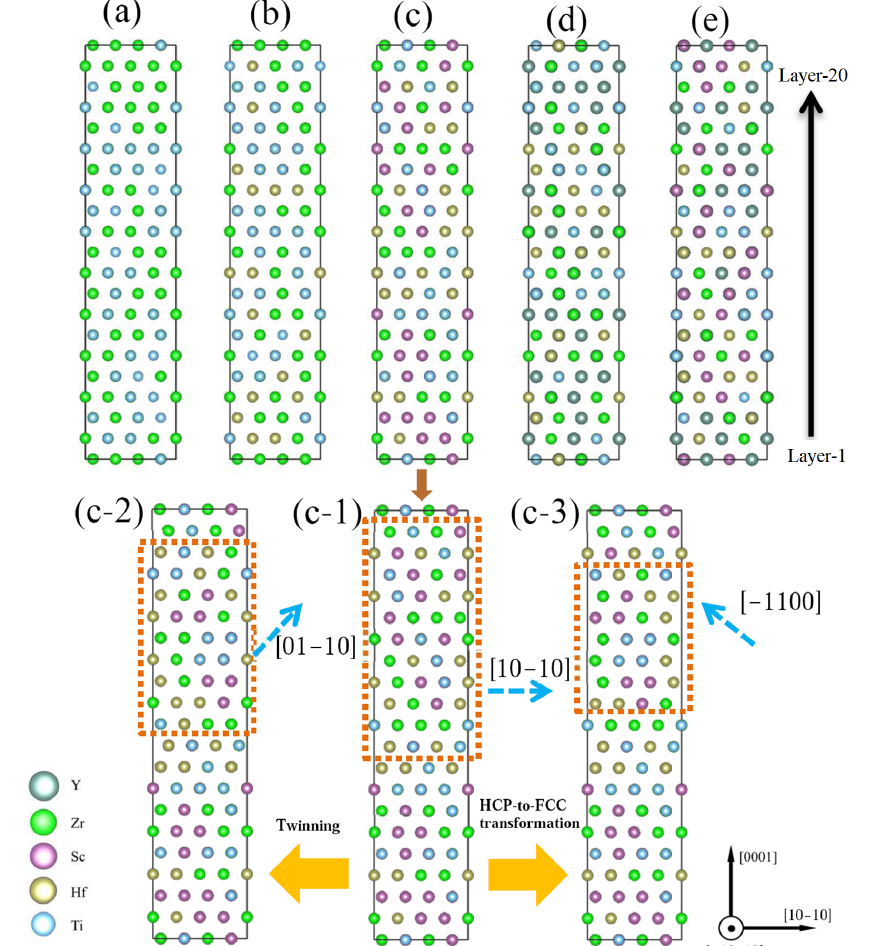
Figure 1. Supercells of CSAs, ( a ) Ti 120 Zr 120 , ( b ) Ti 80 Zr 80 Hf 80 , ( c ) Ti 60 Zr 60 Hf 60 Sc 60 , ( d ) Ti 60 Zr 60 Hf 60 Y 60, and ( e ) Ti 48 Zr 48 Hf 48 Sc 48 Y 48 . The generations of the stacking fault ( c-1 ), faults related to